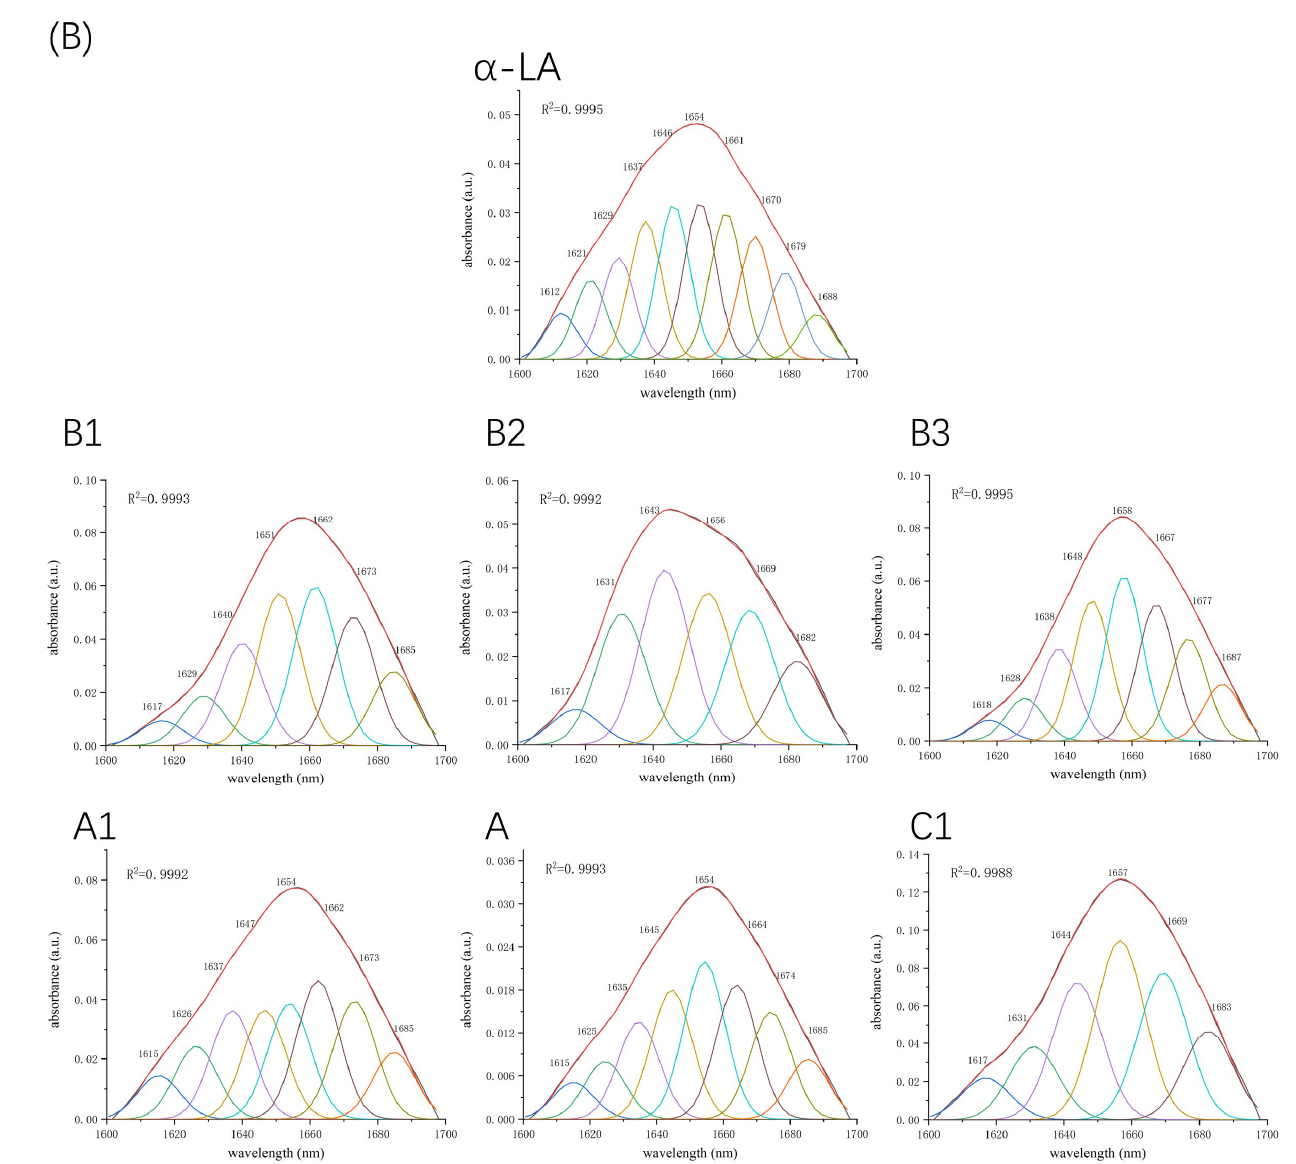
Figure 5. Second derivative analysis and curve-fitted amide I region (1700–1600 cm − 1 ) of FTIR spectroscopy for β -LG ( A ) or α -LA ( B ) with or without proanthocyanidins A1, A2, B1, B2, B3, and